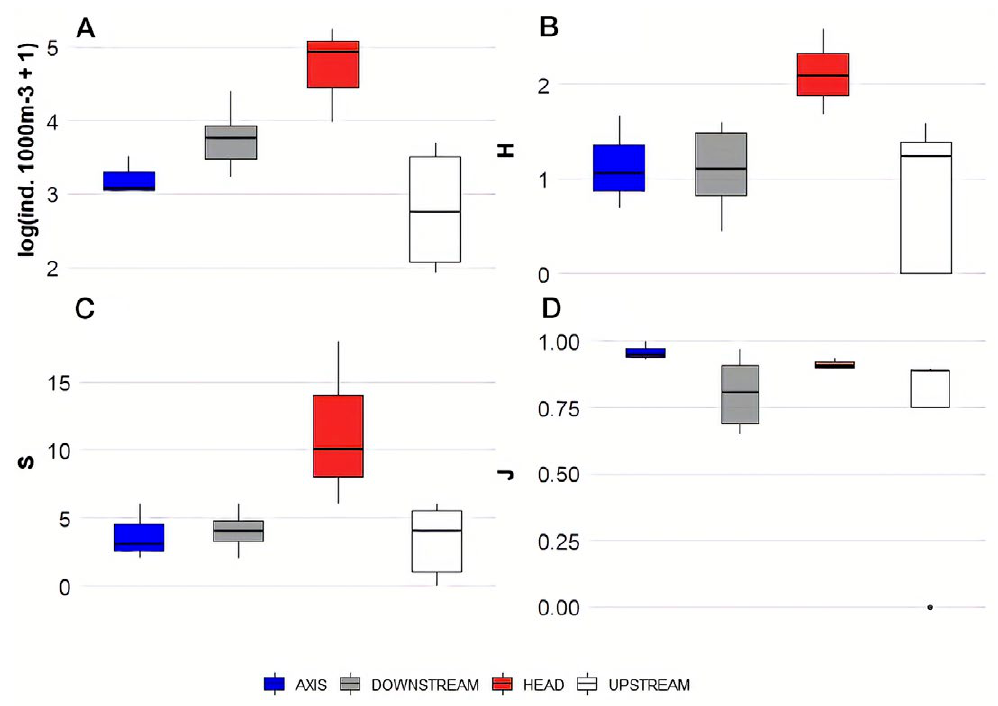
Fig. 6. – Box and whisker diagrams showing median, third quartiles and minimum and maximum values by zone for A, decapod larval density (log(ind./1000 m 3 )+1); B, Shannon diversity index (H); C, species richness (S); D, Pielou evenness index (J). Data from B300.